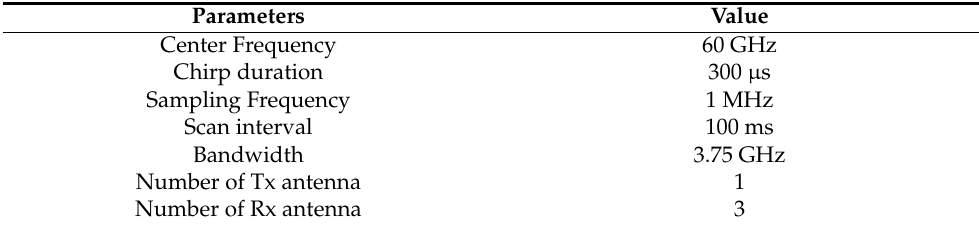
Table 1. FMCW radar specifications.